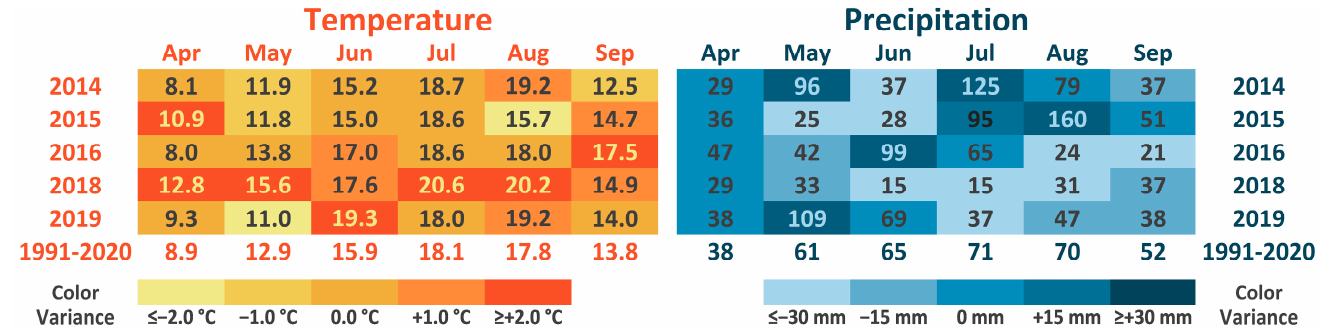
Figure 1. Mean monthly and overall mean temperature (°C) and deviation from mean total monthly pre-cipitation (mm) of the experimental years, compared with long-term (1990–2020) mean temper- ature and mean total monthly precipitation.